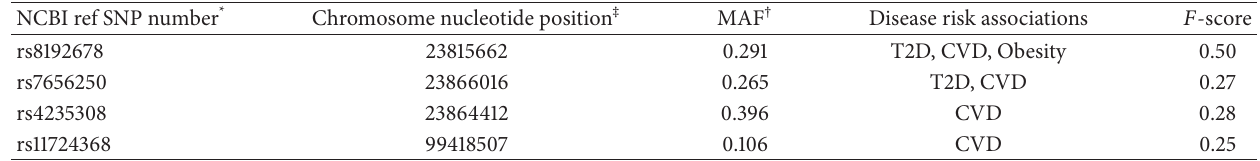
Table 1: Characteristics of PPARGC1A SNPs.